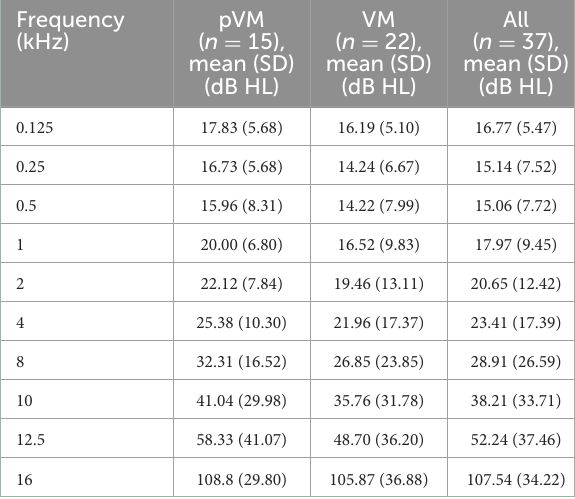
TABLE 2 The threshold of both ears in patients with pVM and VM at standard frequency (SF) and extended high frequency (EHF). Frequency (kHz)